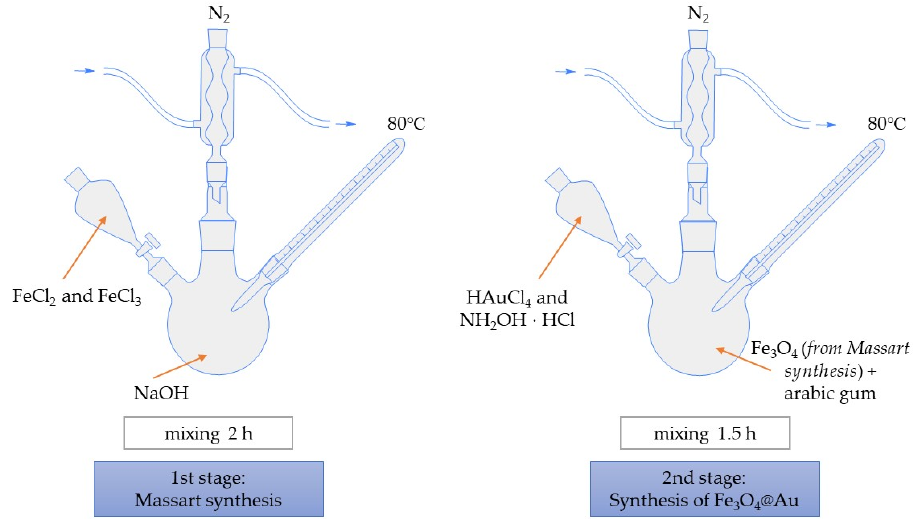
Figure 1. The scheme of Fe 3 O 4 @Au synthesis.